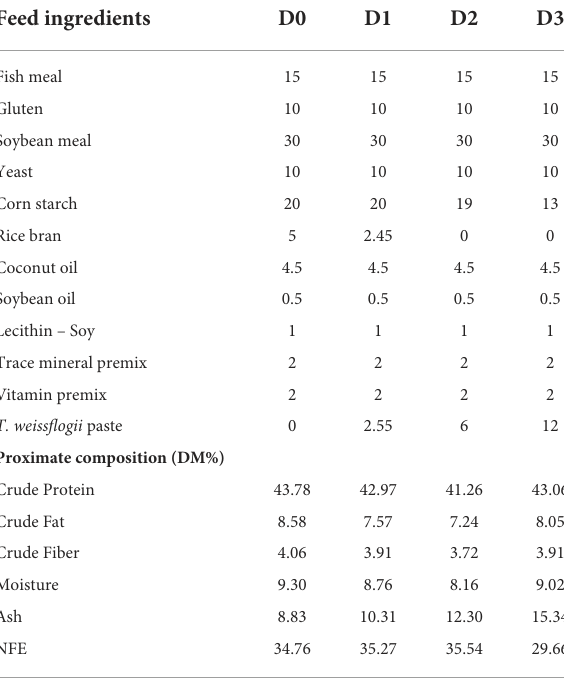
TABLE 2 Fatty acid composition (%) of the experimental